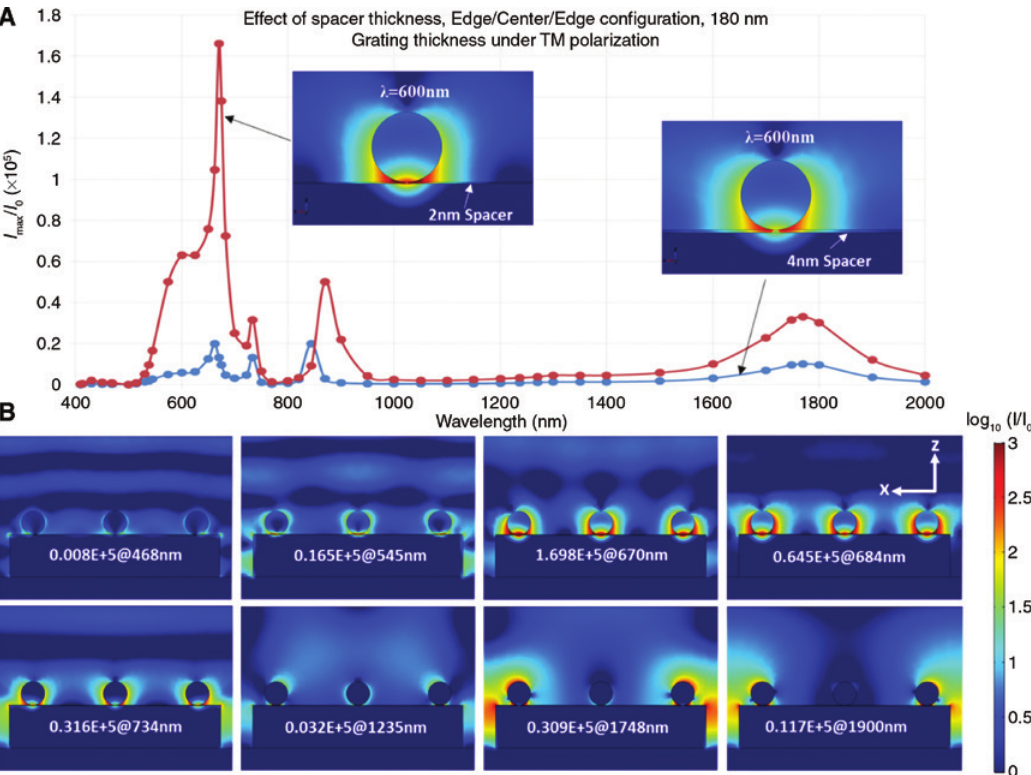
Figure 24: Spacer thickness effect on the field enhancement under thick metal grating geometry. (A) Maximum field intensity enhancement versus wavelength for the edge/center/edge NP grating configuration under TM polarization as in Figure 22A. The grating and spacer thicknesses are 180 nm and 2 or 4 nm, respectively. (B) Intensity distribution at different wavelengths. The legends in the figures in (B) show the maximum intensity enhancement at the specific wavelengths. Reproduced with permission from